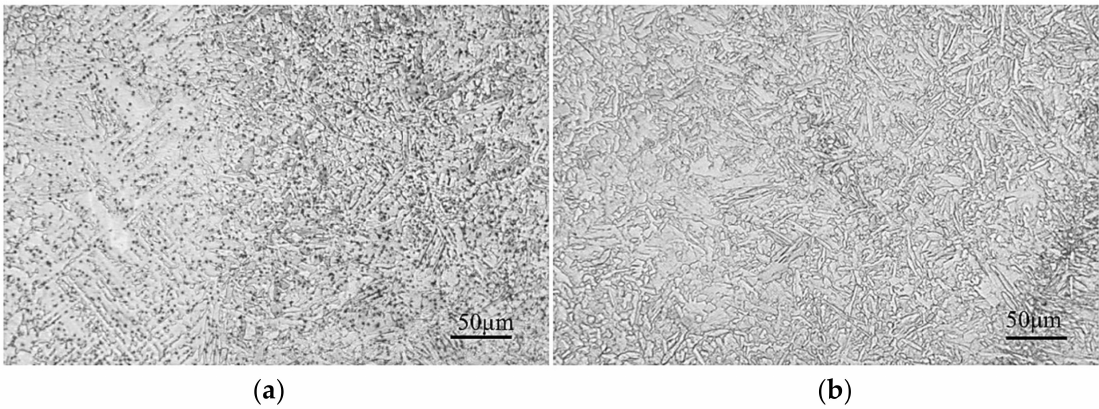
Figure 22. Microstructure of sample: ( a ) bottom section; ( b ) middle section. Reprinted from Ref.